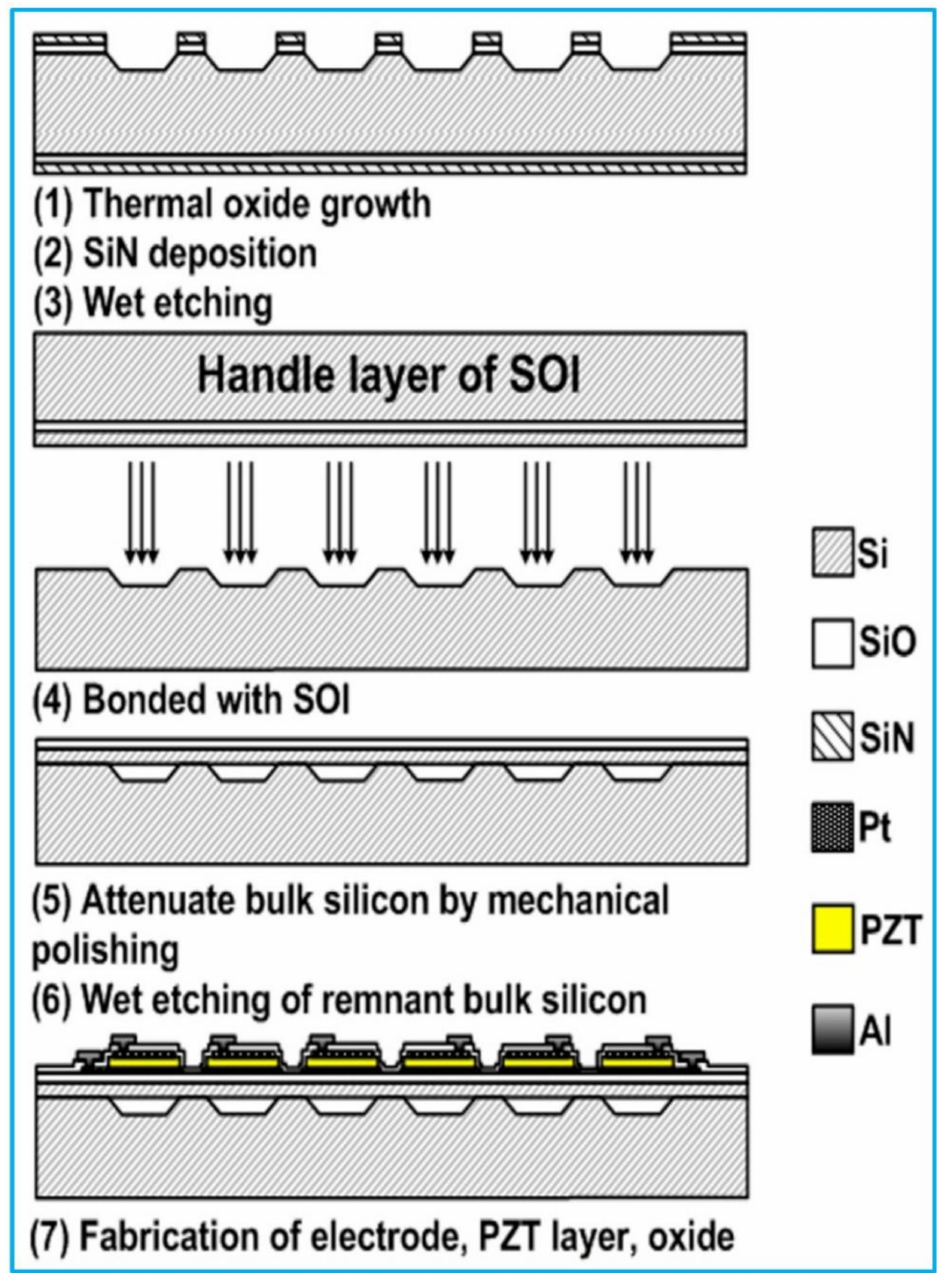
Figure 6. A typical fabrication processes of PMUT by the cavity wafer bonding method. Reprinted from Ref. [125] with